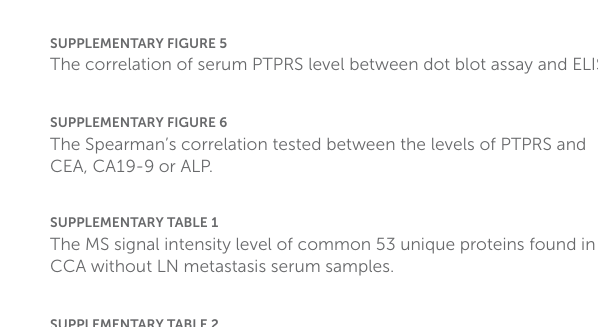
SUPPLEMENTARYFIGURE4 Shuffling of serum samples.